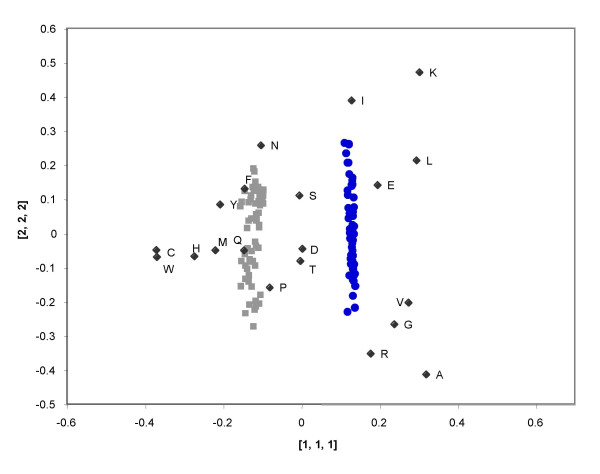
Triplot of [1, 1, 1] and [2, 2, 2] factors. Superimposed plot of the [1, 1, 1] and [2, 2, 2] factors showing the amino acid usage variability, independent of the organisms or functions analyzed. This is a combination of three plots: a) a plot of the first and second principal components of the loadings matrix, A, related to amino acid variation; b) a plot of the first and second principal components of the loadings matrix, B, related to variations associated with functions; and c) a plot of the first and second principal components of the loadings matrix, C, related to variations associated with the organism. The blue circles and grey squares represent the organisms and functions, respectively.